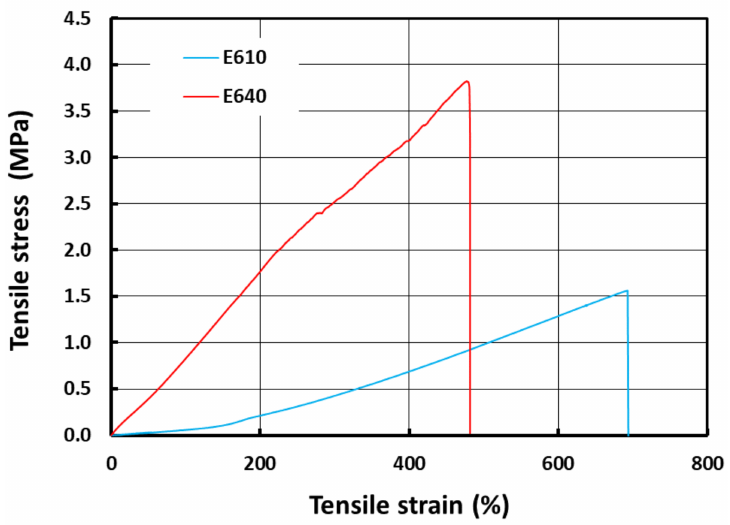
Figure 6. Stress vs. strain in uniaxial tension to fracture of pure silicones (E610 and E640). Figure 7a compares the stress vs. strain relationships of pure E610 and E640 (without pores) in cyclic uniaxial compression at two different strain rates of 10 − 2 /s and 10 − 3 /s. It appears that both silicones only show slight strain hardening effect. In order to have a better view of the residual strain in cyclic testing, the logarithmic plot of stress is used in Figure 7b,c for E610 and E640 samples, respectively. As we can see, the influence of strain rate on the residual strain upon unloading of E610 is far more significant than that of E640. Hence, in terms of the residual strain, E610 is more viscous, while E640 is more elastic. However, for the stress vs. strain relationship in the loading process, the influence of strain rate is not significant. Therefore, a constant strain rate of 10 − 3 /s can be applied to compare the response of all samples in uniaxial compression at room temperature, since the compressive stress in loading is more of our interest.